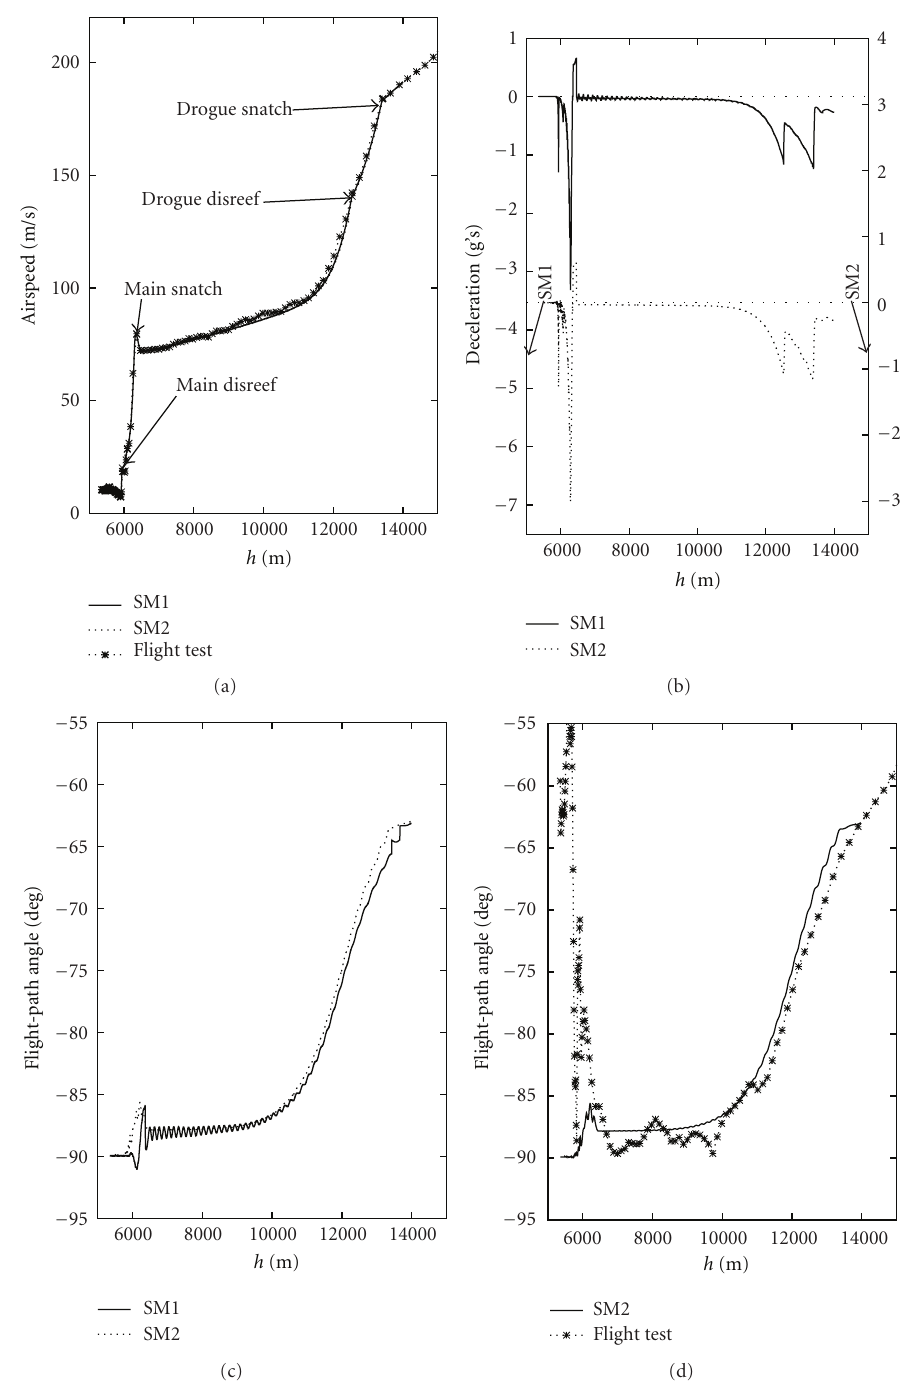
Figure 5: The simulation of the trajectory profile for the parachute-payload